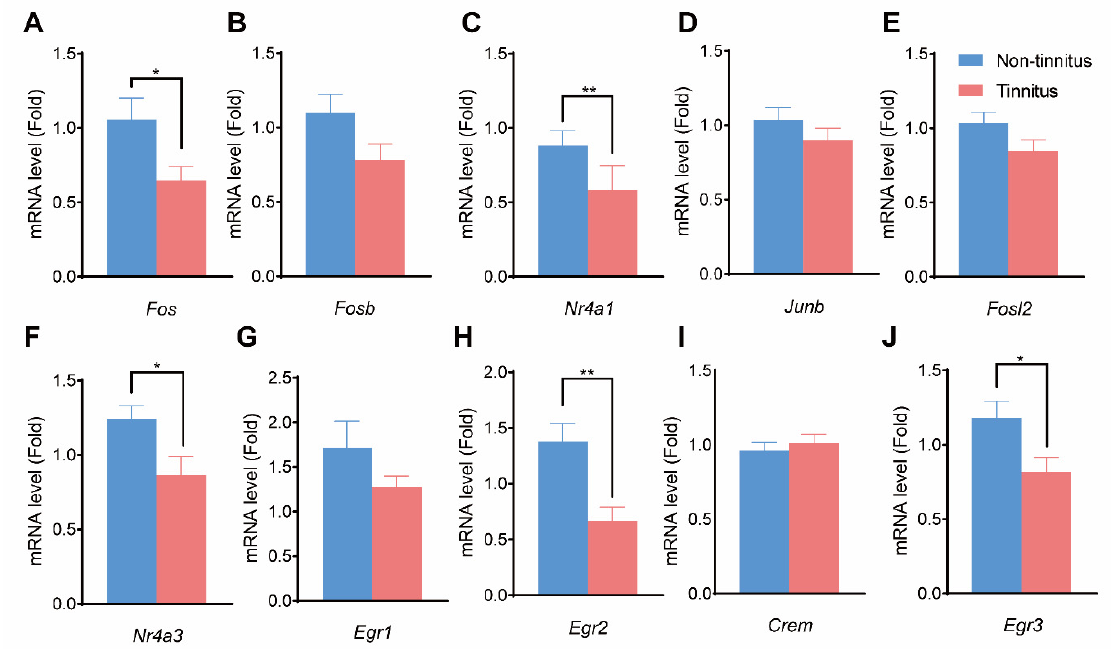
Figure 5. qPCR results of the selected hub genes. ( A – G ) show the mRNA level changes between the non-tinnitus and the tinnitus group including Fos ( A ), Fosb ( B ), Nr4a1 ( C ), Junb ( D ), Fosl2 ( E ), Nr4a3 ( F ), Egr1 ( G ), Egr2 ( H ), Crem ( I ), and Egr3 ( J ). n = 5, * p < 0.05, ** p < 0.01. qPCR: quantitative PCR.